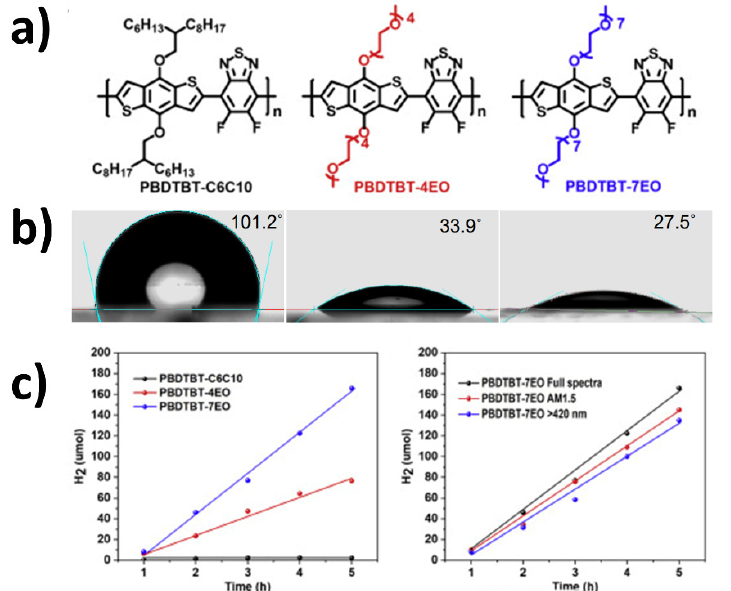
Figure 12. ( a ) Structures of PBDTBT-C6C10, PBDTBT-4EO, and PBDTBT-7EO; ( b ) Contact angles against water for PBDTBT-C6C10, PBDTBT-4EO, and PBDTBT-7EO; ( c ) Sacrificial hydrogen evolution rates of the conjugated polymers under broadband irradiation (left) and sacrificial hydrogen evolution rates of PBDTBT-7EO under broadband > 420 nm, and AM1.5 irradiation (right). [Figure adapted from ref. [94] under CC-BY 4.0 License].